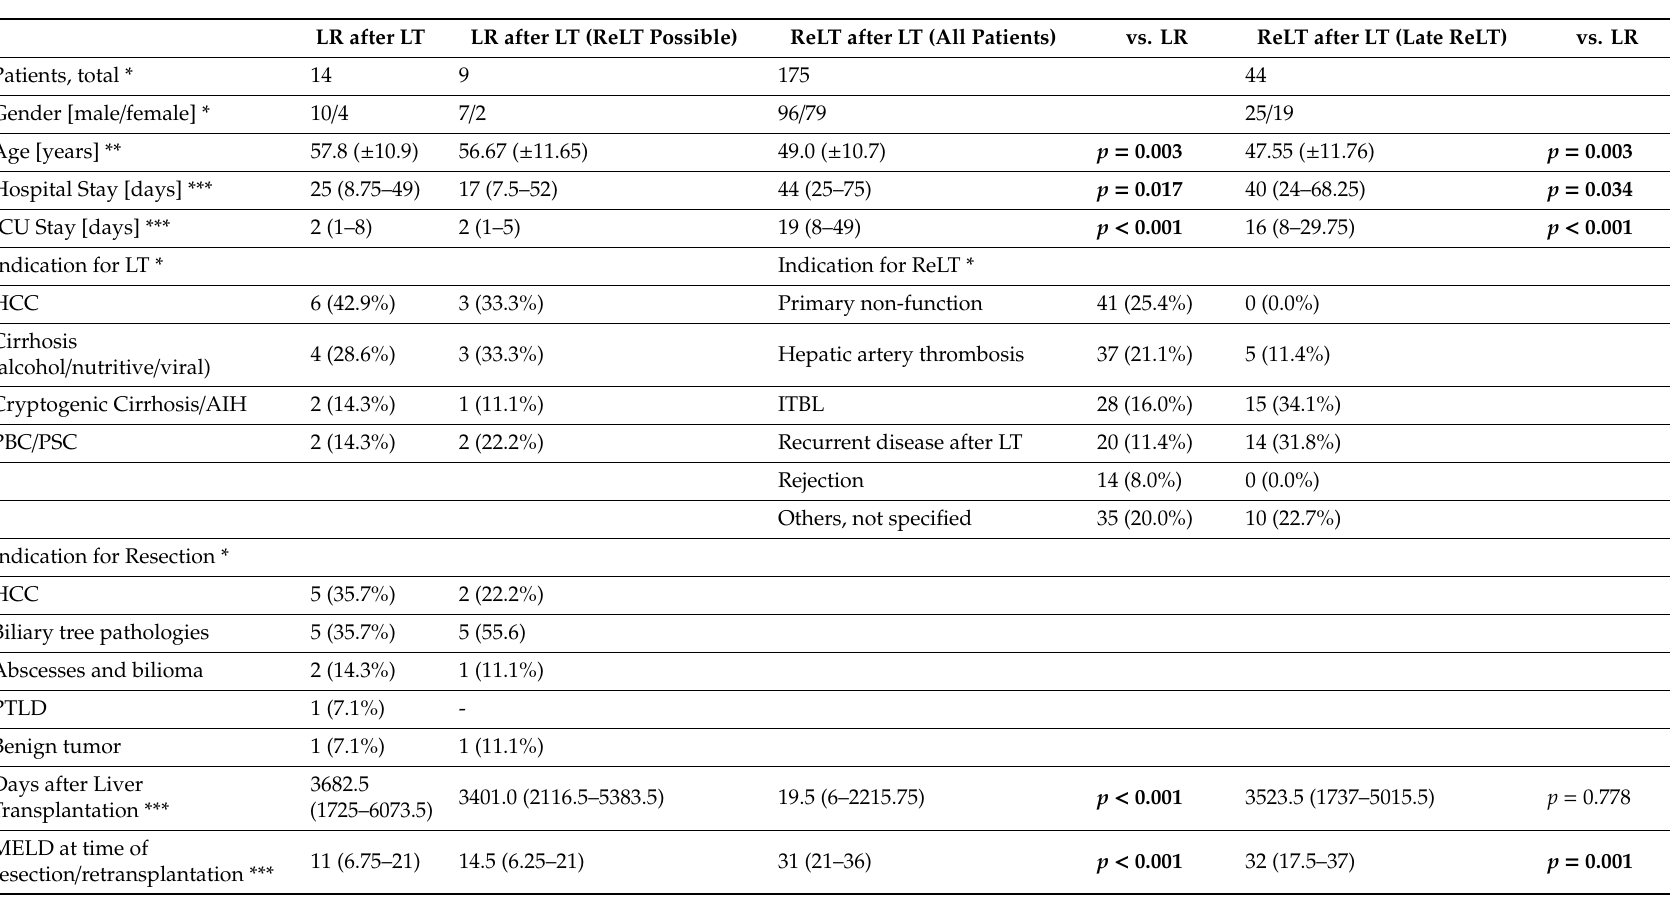
Table 3. Characteristics of the study